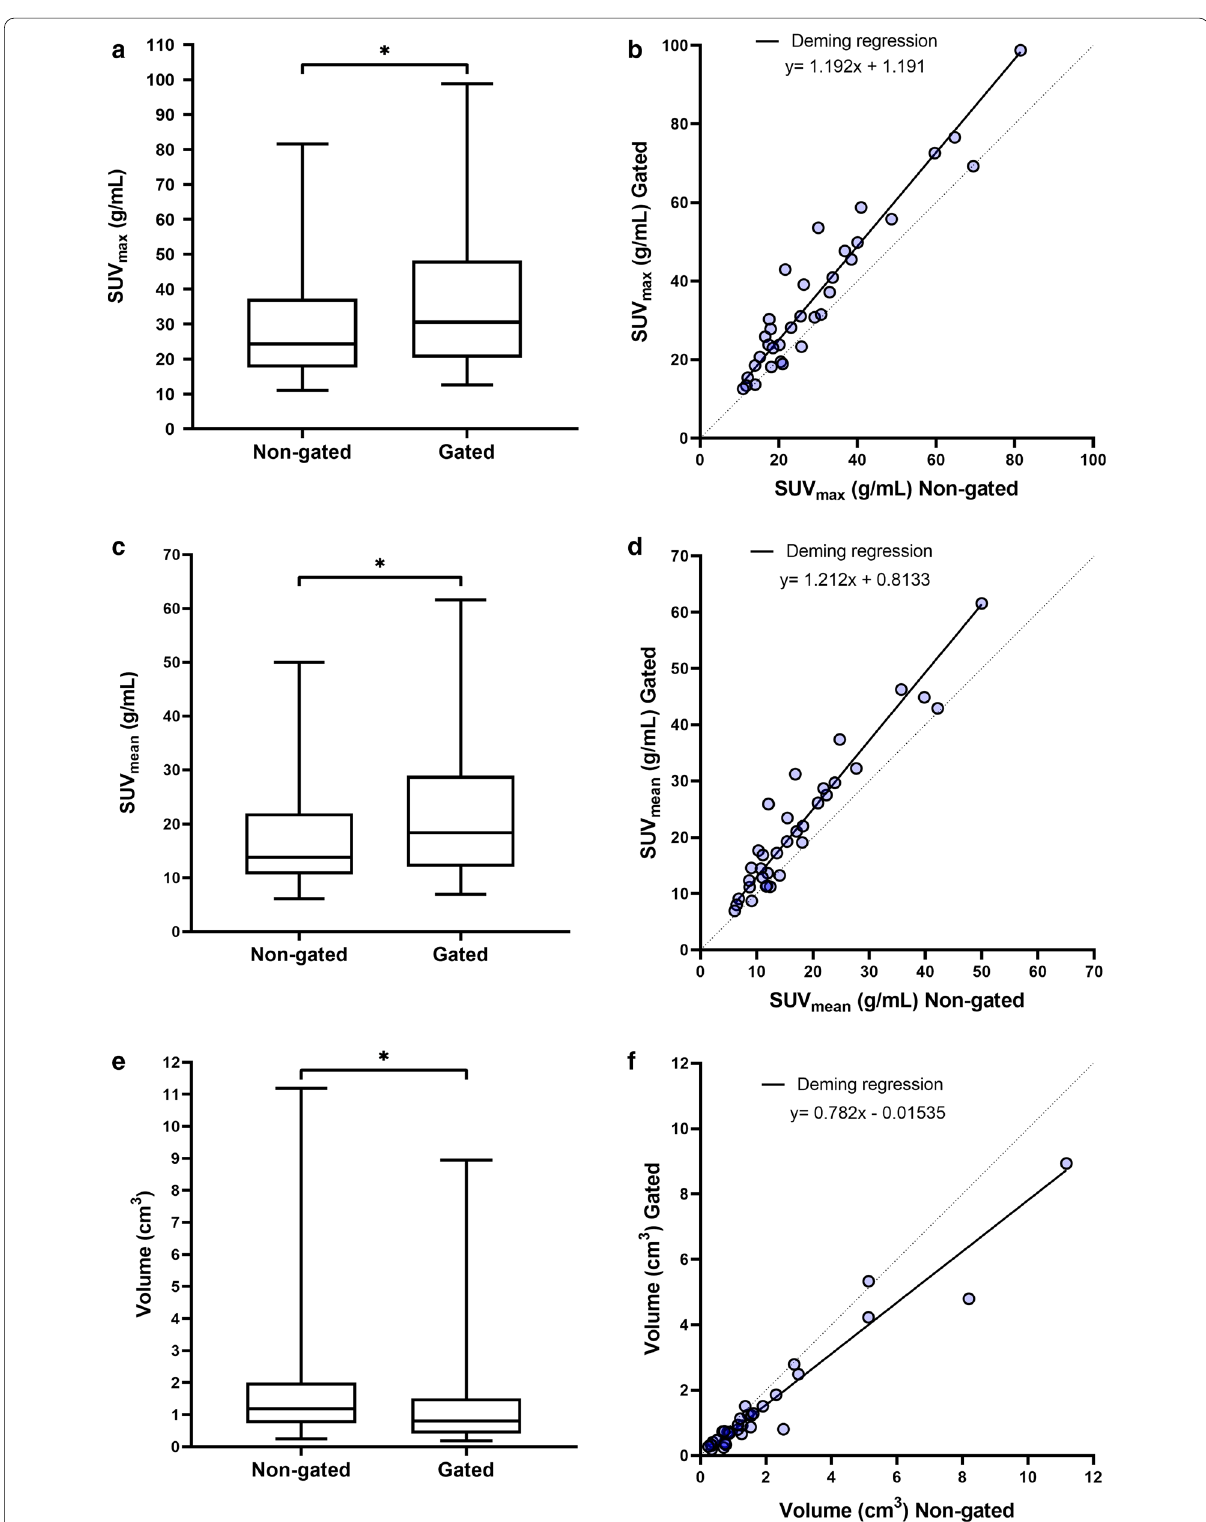
Fig. 2 Box plots showing lesion SUV max ( a ), SUV mean ( c ), and volume ( e ) measured in non-gated and gated PET-images. Whiskers show minimum and maximum values and the asterisk indicates P < 0.05 using Wilcoxon’s signed rank test. Correlation plots showing lesion SUV max ( b ), SUV mean ( d ), and volume ( f ) of gated versus non-gated PET-images. Solid lines represent linear Deming regression and dotted lines represents line of